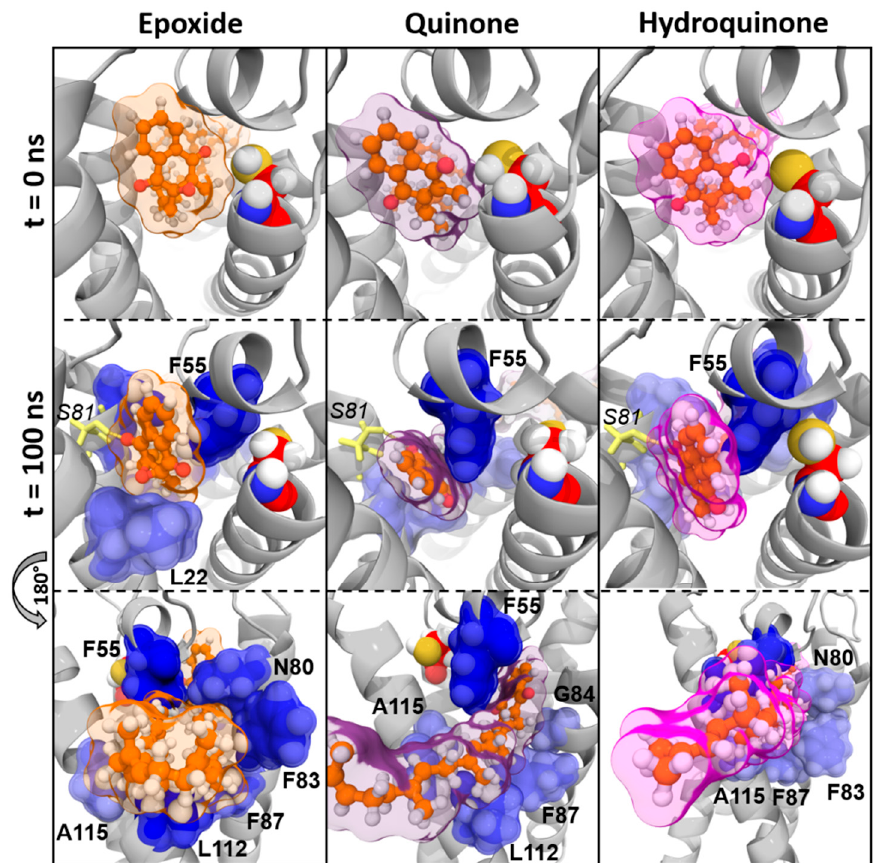
Figure 5. Vitamin MK7 interactions with vitamin K epoxide reductase (VKORC1) in molecular dynamics (MD) simulations. Vitamin MK7 is shown as orange sticks and spheres; the transparent surface is colored as orange, violet, and pink for epoxide, quinone, and hydroquinone states of vitamin MK7, respectively. The VKORC1 protein structure is depicted as a grey image; C135 residue is presented as red spheres. Oxygen, nitrogen, sulfur, and hydrogen atoms are colored in red, blue, yellow and white, respectively. VKORC1 residues involved in hydrogen bonds with vitamin MK7 are shown as yellow sticks (hydrogen bonds are depicted as yellow dashes) and numbered in italic characters. VKORC1 residues contributing to vitamin MK7–VKORC1 binding free energy are presented as blue spheres and a transparent surface (the darker the blue is, the stronger the interaction is) and numbered in bold characters.